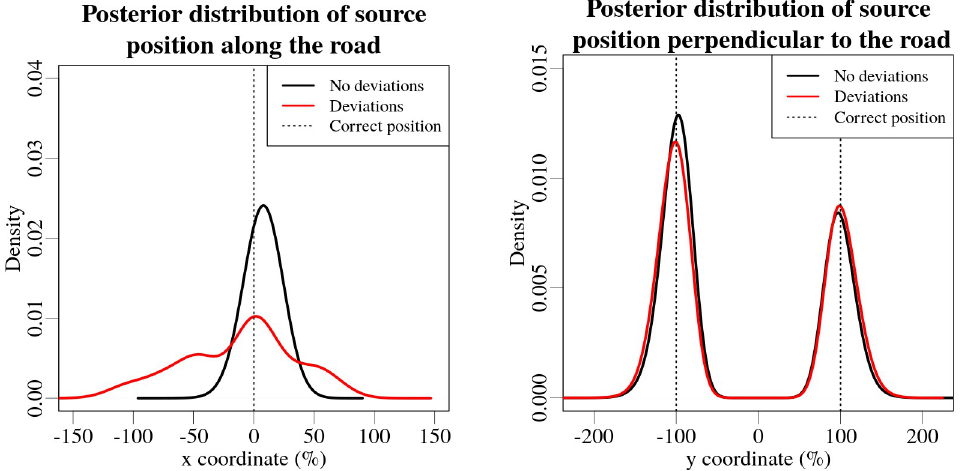
Fig 11. Posterior distributions for longitudinal (left) and lateral (right) coordinates for modelled data without (black line) and with (red line) the synthetic deviations in the measurement coordinates. The vertical dashed lines marks the correct positions of the source. The coordinates are expressed in terms of percent of the distance to the source (30 m).